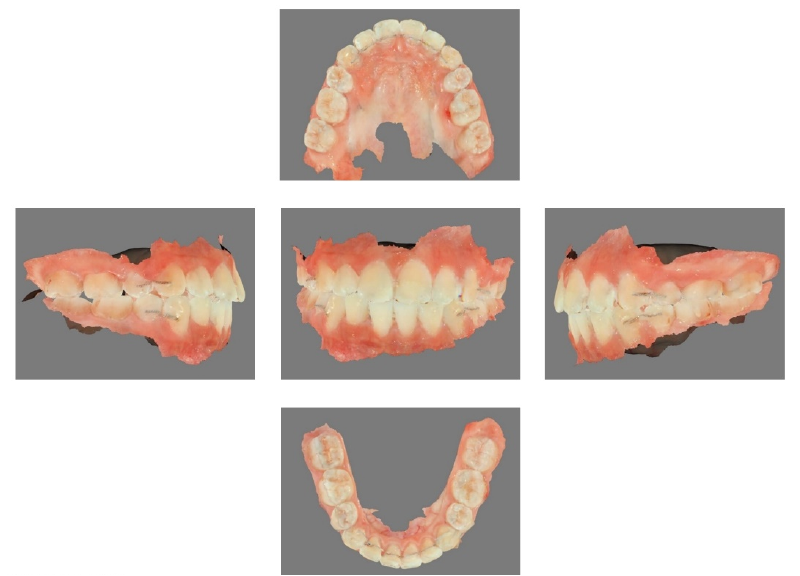
Figure 3. Photo taken directly from intraoral dentition using an intraoral scanner. First, each member of the dentition of the maxilla and mandible is scanned, then the patient is occluded, and then the current occlusion is also scanned.